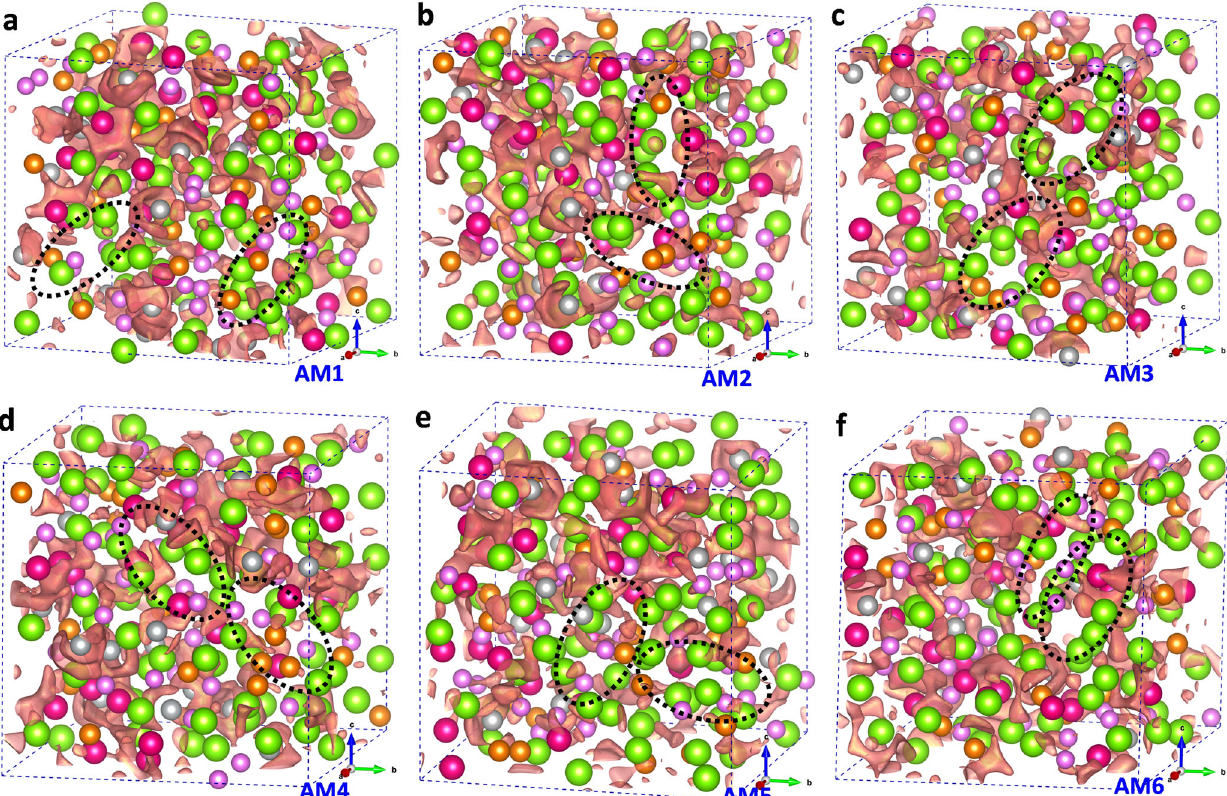
Fig. 6 Bonding-charge-density isosurface ( Δ ρ = 0.008 e - Å − 3 ) of Vitreloy-1MG (Zr 41 Ti 14 Cu 12.5 Ni 10 Be 22.5 ), Vit1 . TheAM1 — AM6 con fi gurations are initially generated by running thousands of AIMD steps (time ≥ 10 ps) at 937, 1000, 1100, 1200, 1300, and 1500 K, respectively, and subsequently fully relaxed at 0 K. The yellow , green , pink , gray , and magenta colors are used to identify the Zr, Hf, Ti, Ni, and Be atoms, respectively. Soft and stiff zones related to free volume and clusters are clearly revealed by low and high values of Δ ρ . Plots of the Δ ρ isosurfaces are generated by the VESTA code